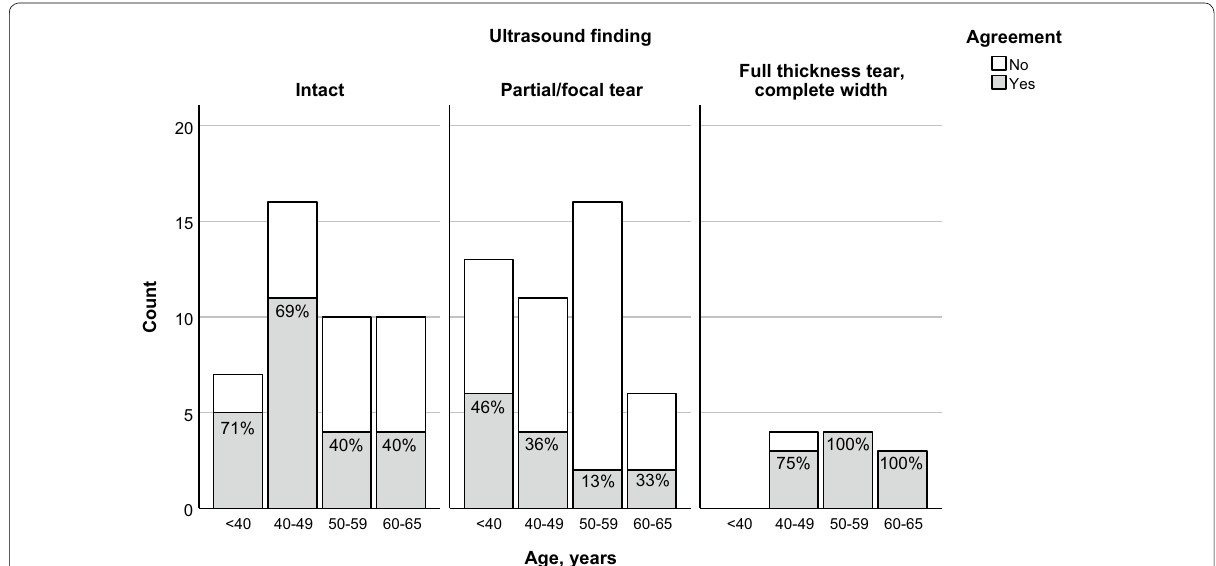
Fig. 1 Proportion of patients with agreement by age, stratified by type of ultrasound